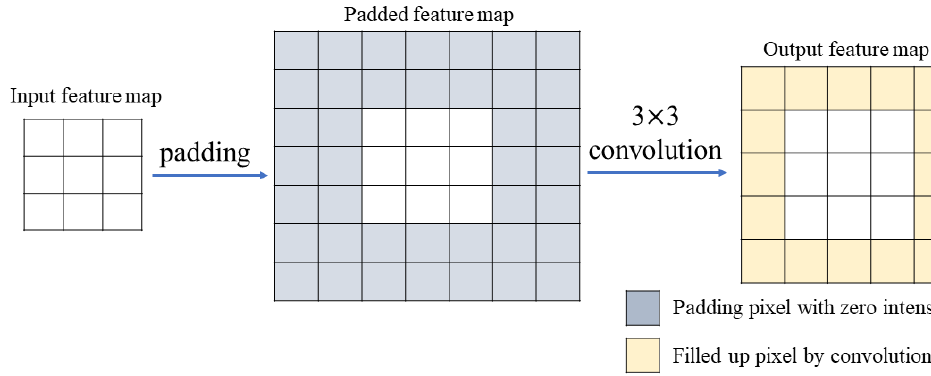
Figure 3. Mechanism of deconvolution operation.